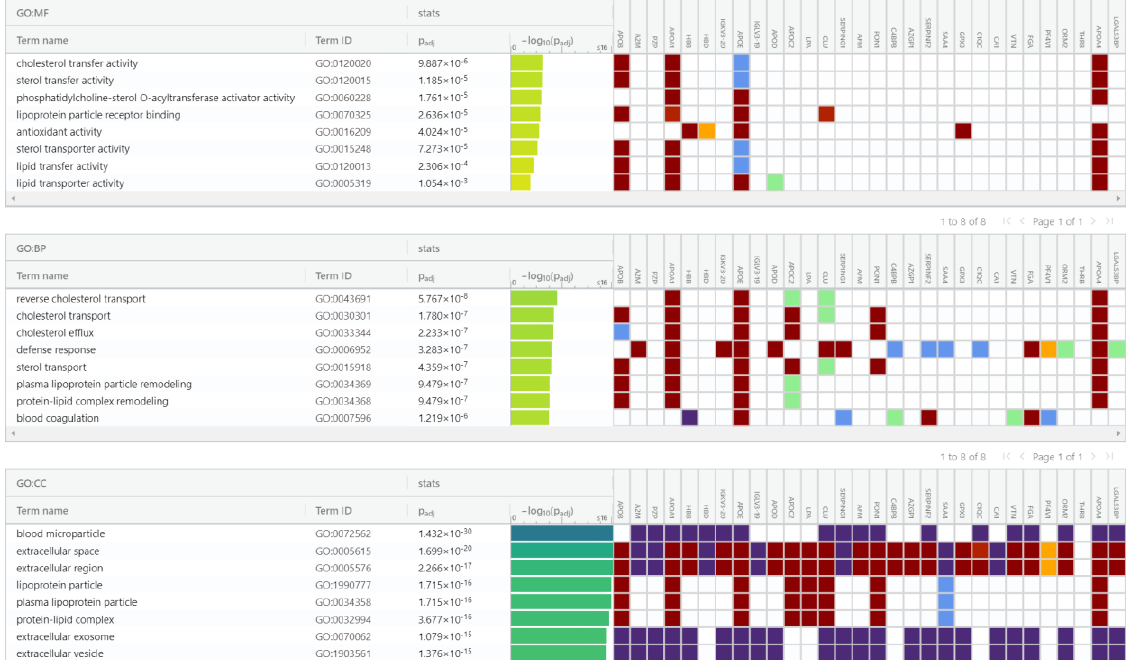
Figure 10. gProfiler classification of proteins in the EC serum exosomes according to their molecular function, biological processes, and cellular component.